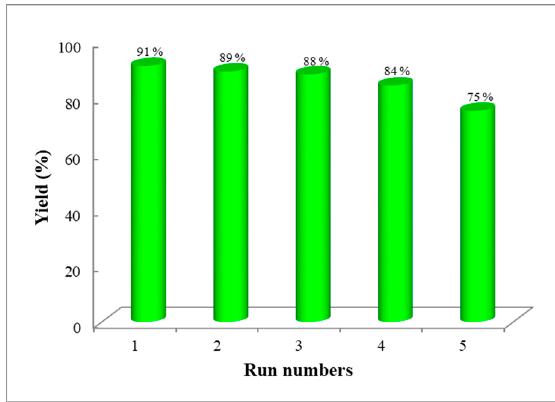
Figure 5. Recycling use of the WEPPA in the synthesis of 4-fluorobenzamide 2g .